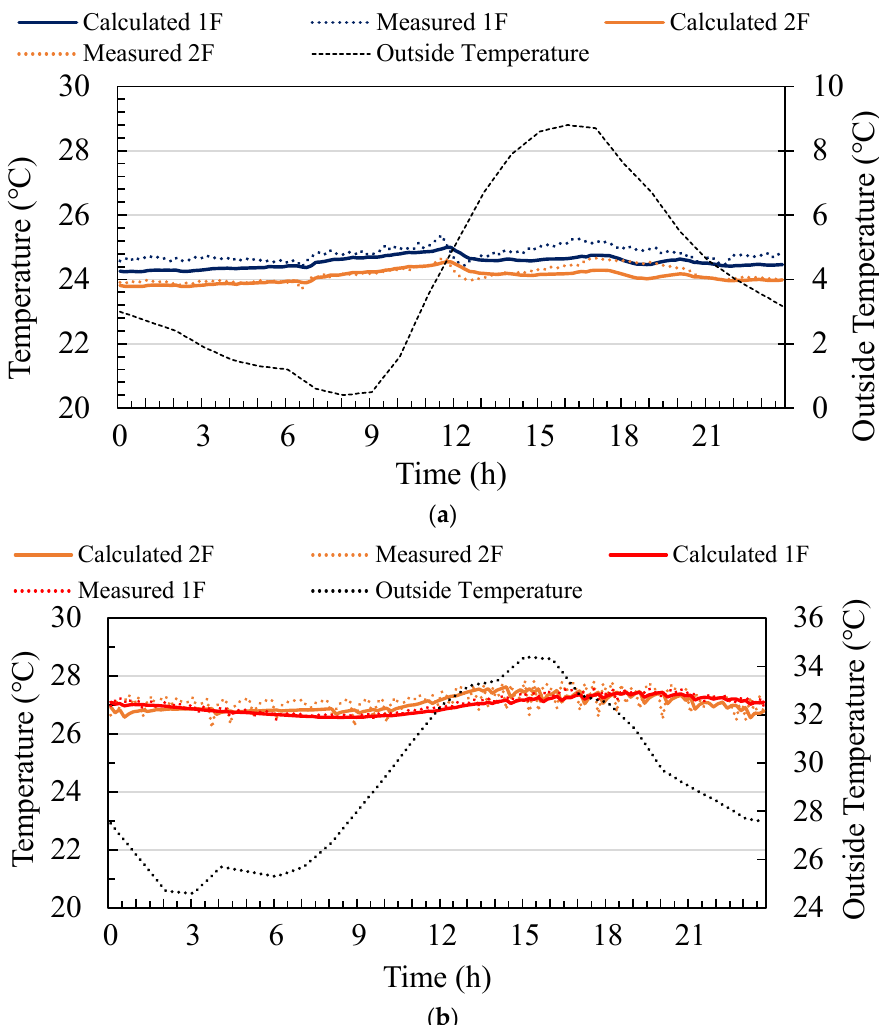
Figure 6. Results of Step 2 accuracy verification ( a ) in winter and ( b ) in summer. 1F, first floor; 2F, second floor.